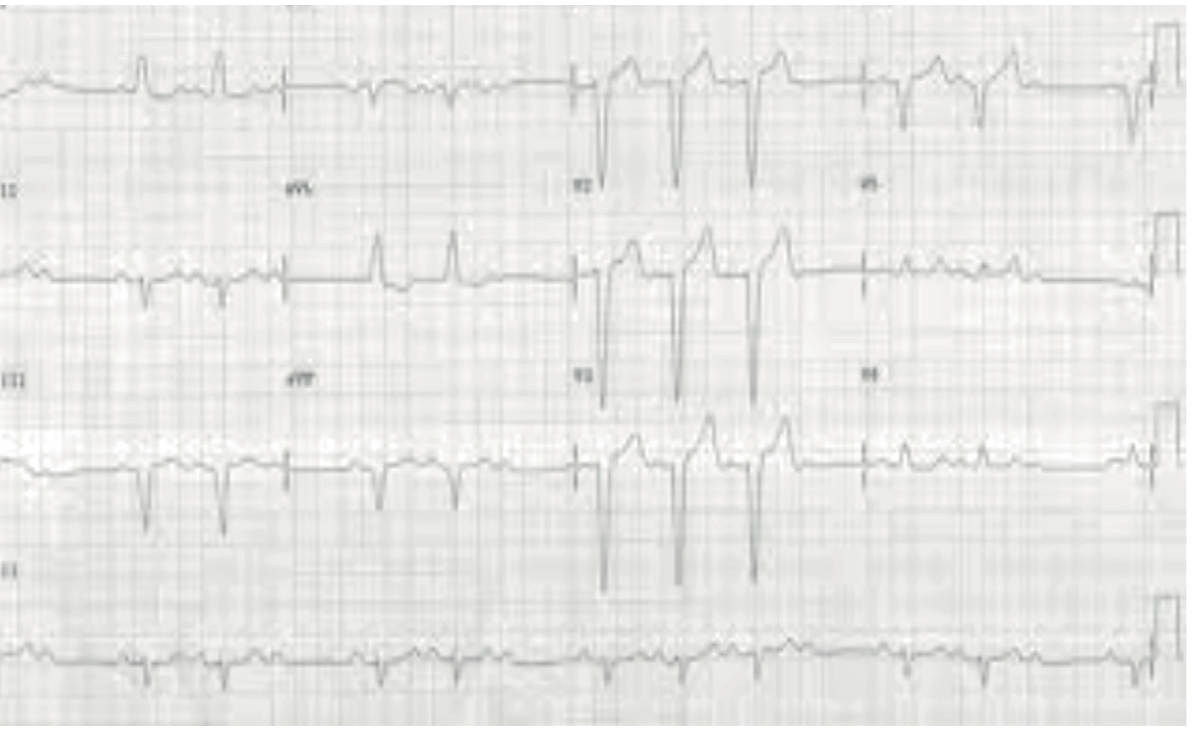
Figure 4 - ECG changes compatible with right ventricular overload Source: Research